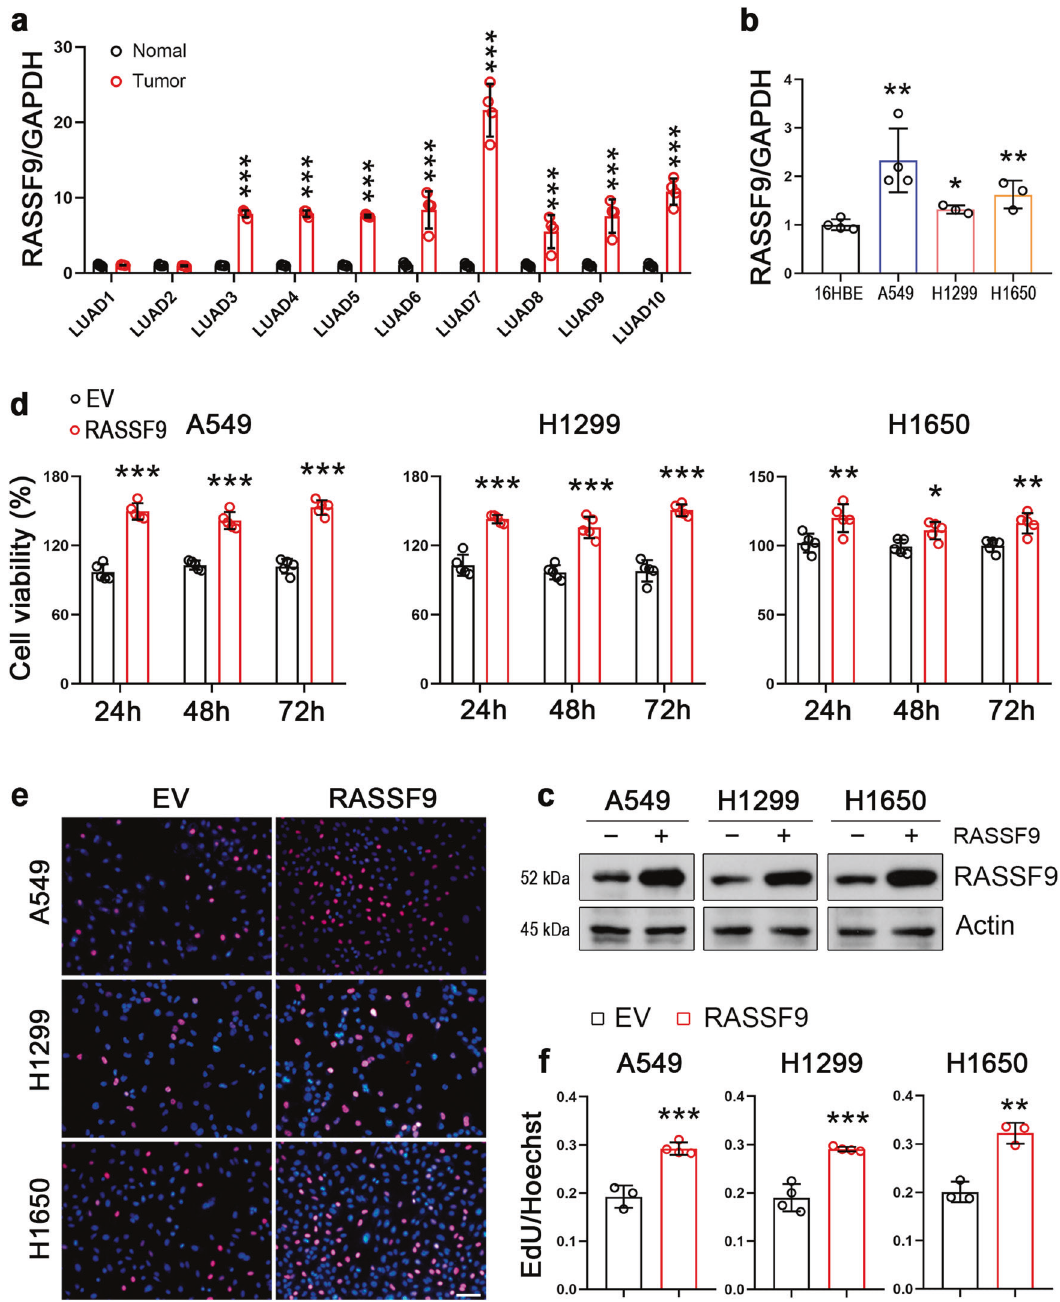
Fig. 1 RASSF9 is highly expressed in NSCLC and plays a role in stimulating tumor cell proliferation. a The mRNA levels of RASSF9 in normal and NSCLC tissues. n = 10. b The mRNA levels of RASSF9 in human bronchial epithelial cells (16HBE) and NSCLC tumor cell lines (A549, H1299, and H1650). c RASSF9 was increased by the transfection with the plasmid carrying Rassf9 . The control cells were transfected with the empty vector pcDNA3.1. Twenty-four hours post-transfection, cells were harvested for analyzing RASSF9 by western blot. Actin was used as a loading control. d RASSF9 improves cell viability. A549, H1299, and H1650 cells were transfected with plasmid expressing Rassf9 and cell viability was analyzed by the method of MTT at different time points as indicated. The control cells were transfected with the empty vector pcDNA3.1 (EV). e RASSF9 promotes cell proliferation. A549, H1299, and H1650 cells were transfected with the plasmid expressing Rassf9 . Twenty-four hours post-transfection, cell proliferation was analyzed by EdU incorporation assay. The control cells were transfected with the empty vector pcDNA3.1 (EV). Scale bar = 500 μ m. f Quantitative analysis of EdU incorporation. Data are presented as means ± SD (error bars). * P < 0.05, ** P < 0.01, and *** P < 0.001. Student ’ s t